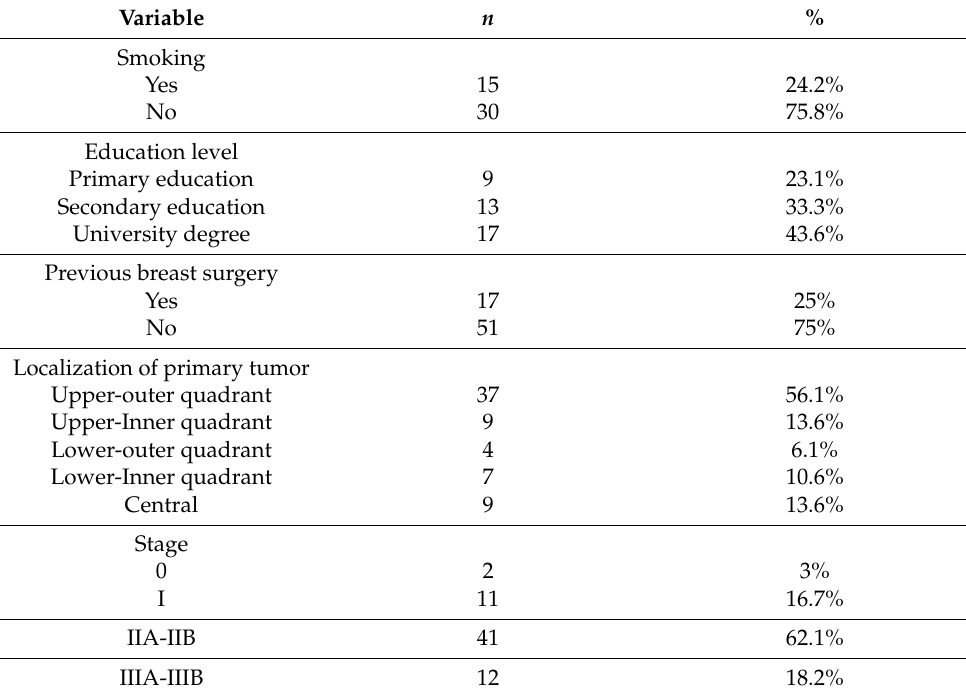
Table 2. Demographic characteristics and preoperative conditions